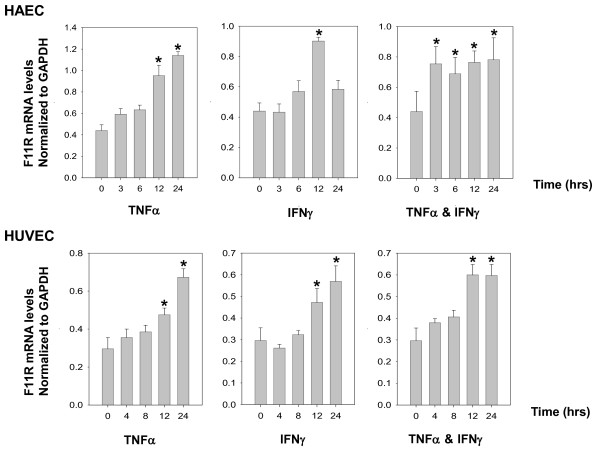
Expression of F11R mRNA in human aortic endothelial cells (HAEC) and umbilical vein endothelial cells (HUVEC) exposed to proinflammatory cytokines TNFα and/or IFNγ: time course. Real-time PCR was performed in cultured HAEC (top panels) treated for 0, 3, 6, 12, and 24 hrs with TNFα (100 u/mL) and/or IFNγ (200 u/mL), and in cultured HUVEC (bottom panels) treated for 0,4,8,12, and 24 hrs with TNFα (100 u/mL) and/or IFNγ (200 u/mL). Real-time PCR was performed three times in triplicate for each time point. Values represent the mean ± SEM. *P < 0.05 indicates the level of significance determined at a specific interval of time of cytokine- treatment of ECs in comparison to the zero time points.